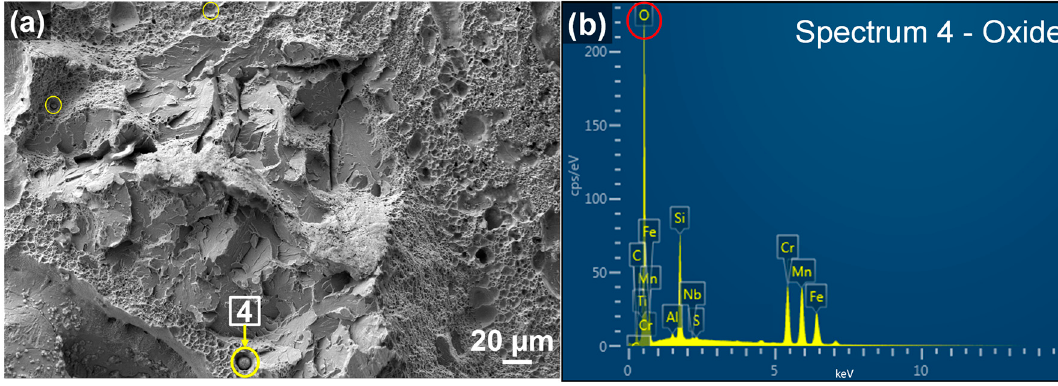
Figure 8. ( a ) SEM micrograph showing oxide inclusions marked by circles; and ( b ) the EDS spot spectrum of the inclusion marked by an arrow from ( a ).